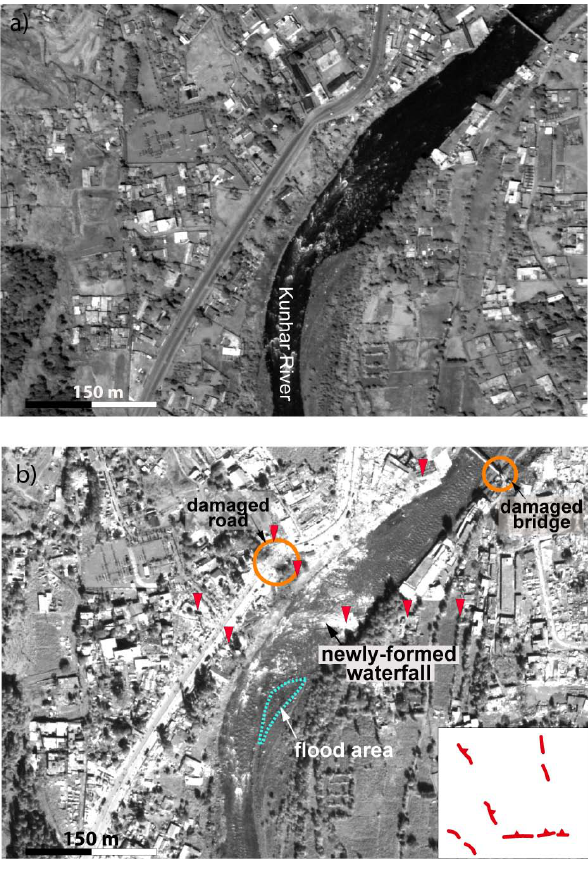
Fig. 7. (a) Pre-event image (11 August 2005) centred on down- town Balakot. (b) Post-event image (19 October 2005) of the same area. Surface traces are pointed (red triangles), as well as signifi- cant damaged and coseismic changes within the river course. The inset shows the pattern of the traces in detail (S-facing monocline, 1 . 45 ± 0 . 15m of vertical